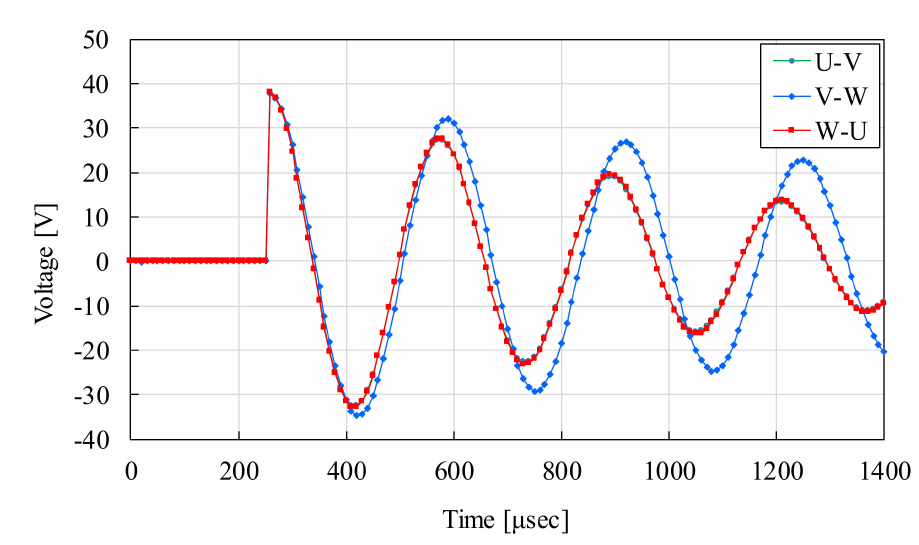
Figure 5. Waveform of a one-turn